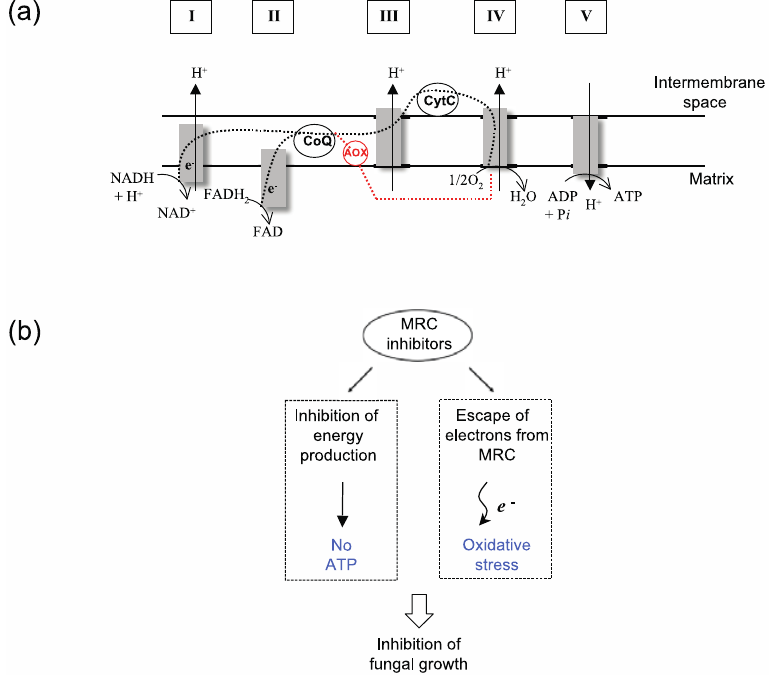
Figure 1. MRC as a target for control of fungal pathogens. ( a ) Schematic representation of MRC (Adapted from [2] and [7]). CoQ, Coenzyme Q; CytC, Cytochrome C; e − , Electrons; AOX, Alternative oxidase; Dashed lines (black), Normal route for electron flow; Dashed lines (red), Alternative route for electron flow; I to V, components/complexes of MRC. ( b ) Mechanism of antifungal action of MRC